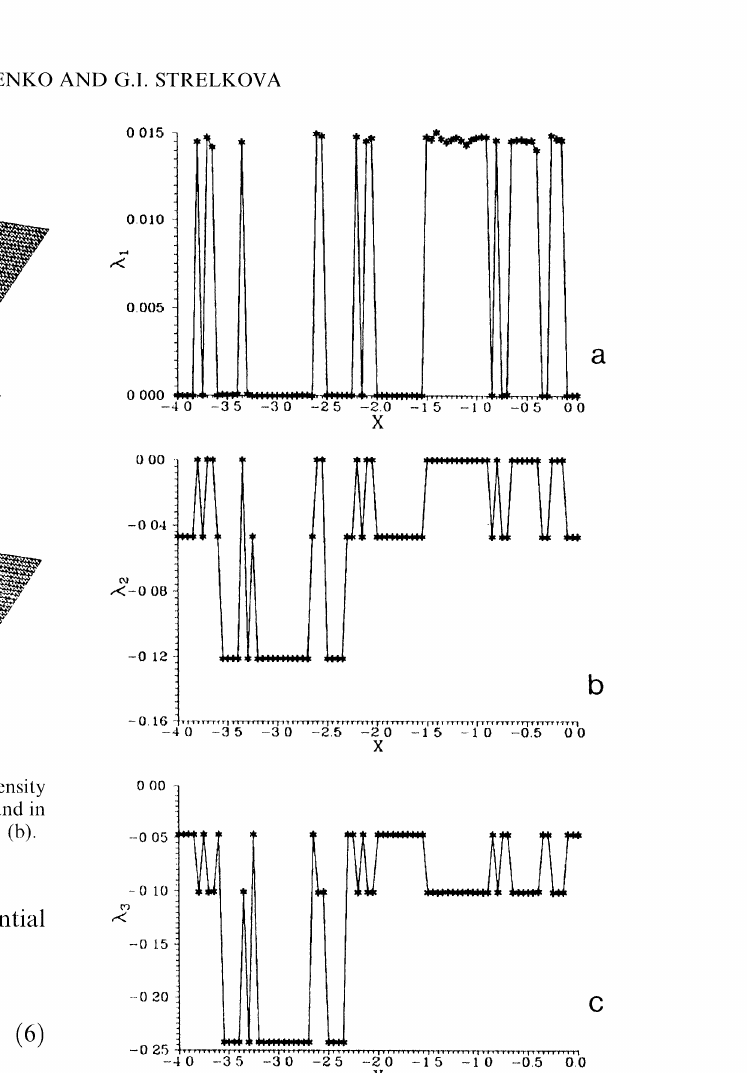
FIGURE 7 Stationary two-dimensional probability density p(x, z) of the Lorenz attractor in the absence of noise (a) and in the presence of additive white noise with intensity d= 0.8 (b).